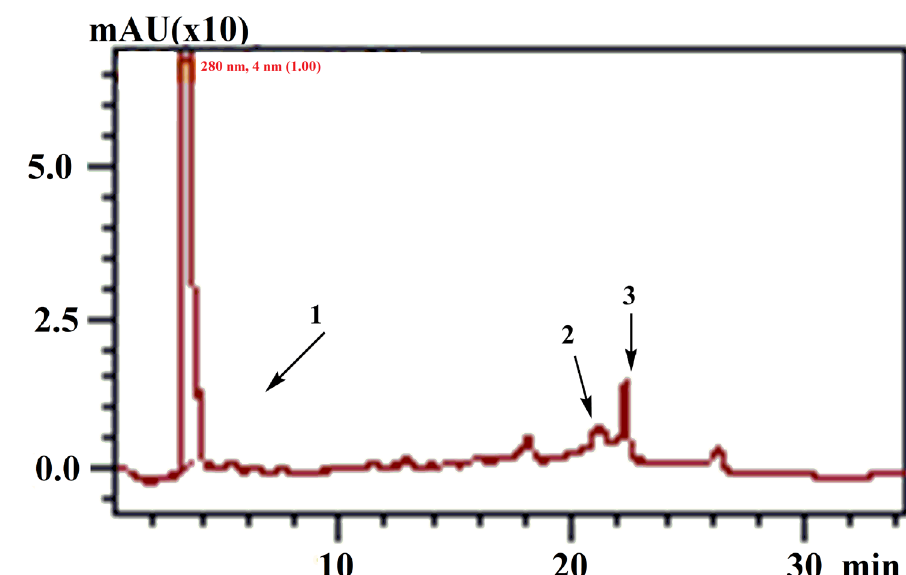
FIGURE 4 - HPLC chromatogram of L. annuus seed coat methanol extract. The peaks correspond to: 1 gallic acid (280 nm wavelength); 2 epicatechin (260 nm wavelength); 3 caffeic acid (280 nm